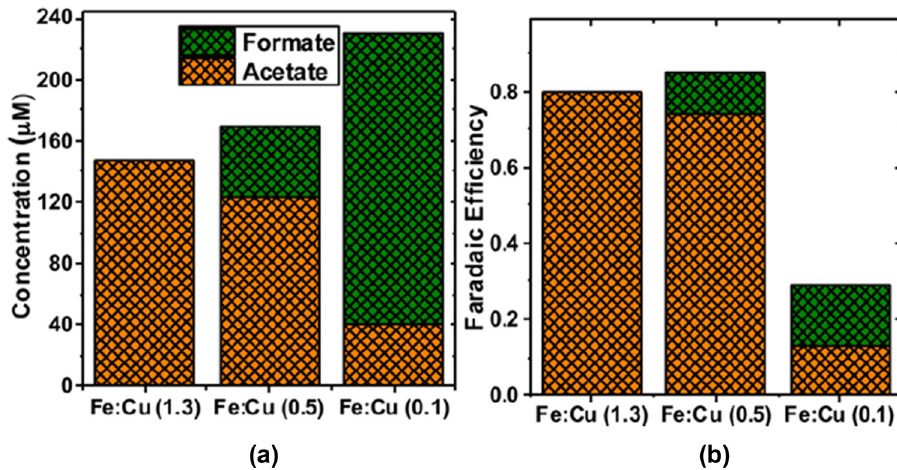
Figure 6: ( a ) Concentration of formate and acetate and ( b ) the corresponding Faradaic e ffi ciencies after photoelectrolysis using CuFeO 2 electrodes with various Fe:Cu atomic ratios. ( Reprinted with permission from ref. [ 149 ] . Copyright © 2017, American Chemical Society )